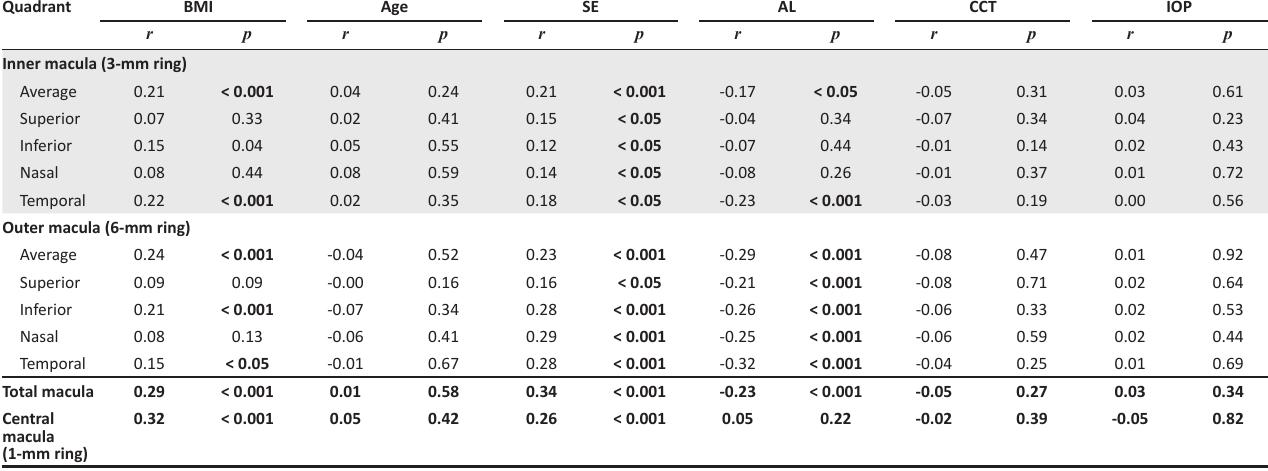
TABLE 3: Correlations between macular measurements and body mass index, age, spherical equivalent, axial length, central corneal thickness and intra-ocular pressure.